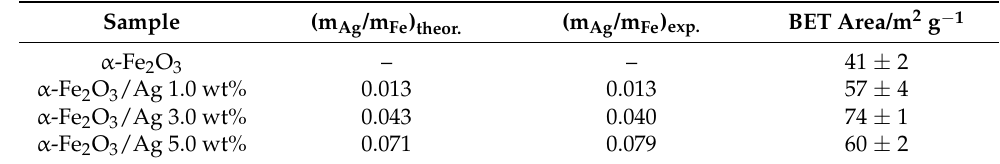
Table 1. Elemental composition and specific surface area of hematite and α -Fe 2 O 3 /Ag nanocompos-